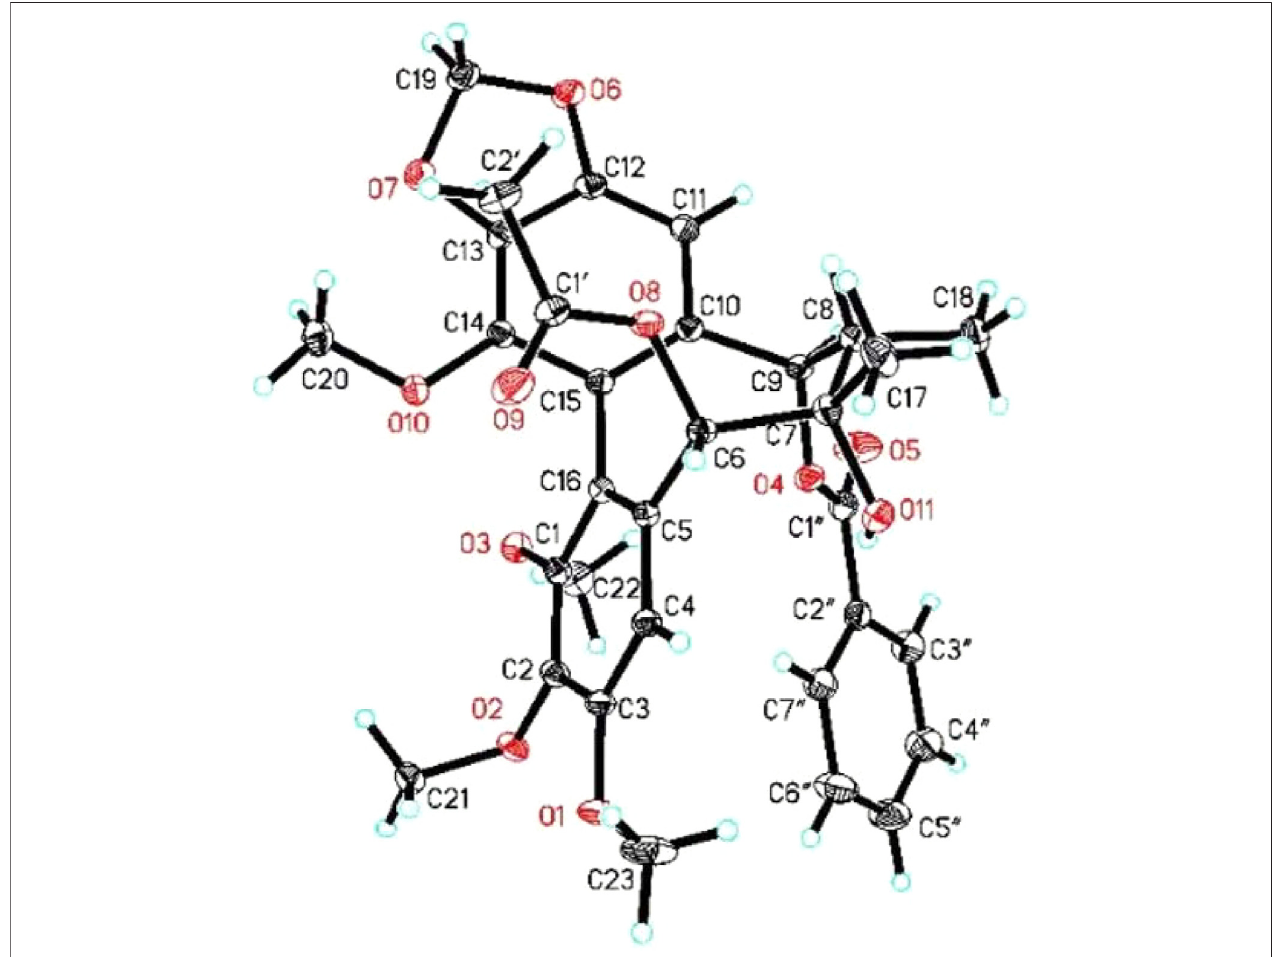
FIGURE 4 | X-ray ORTEP drawing of 21